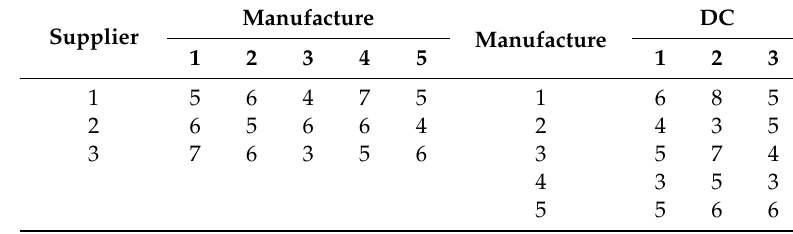
Table 12. Unit shipping cost for each stage (US$) in Experiment 3.